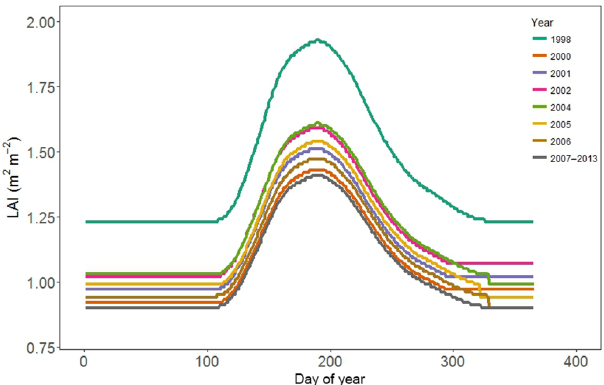
Figure 4. The measured versus the modelled stomatal conductance ( g st ) for the parameterisation dataset (a) ( n = 205) and the valida- tion dataset (b) ( n = 205). The black line is the 1:1 line. The red line is the linear fit for which the equation is given in the figure. Also shown are the p values of the tests for the slope being different from 1 ( p a ) and the intercept different from 0 ( p b ) . Table 1. The optimised parameter values of the multiplicative stom- atal